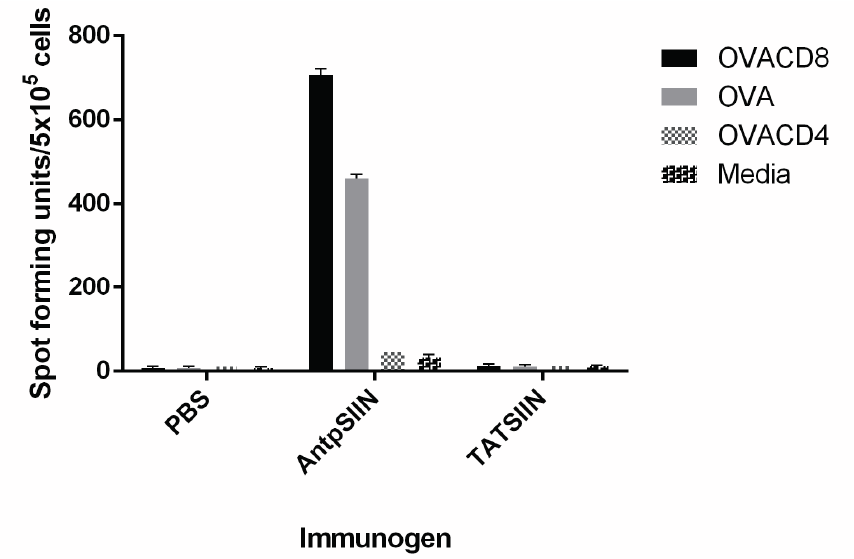
Figure 3. In vivo IFN- γ response to AntpSIIN and TATSIIN immunisation. C57BL/6 mice were injected i.d. on days 0, 10 and 17 with PBS, 25 µg AntpSIIN or 25 µg